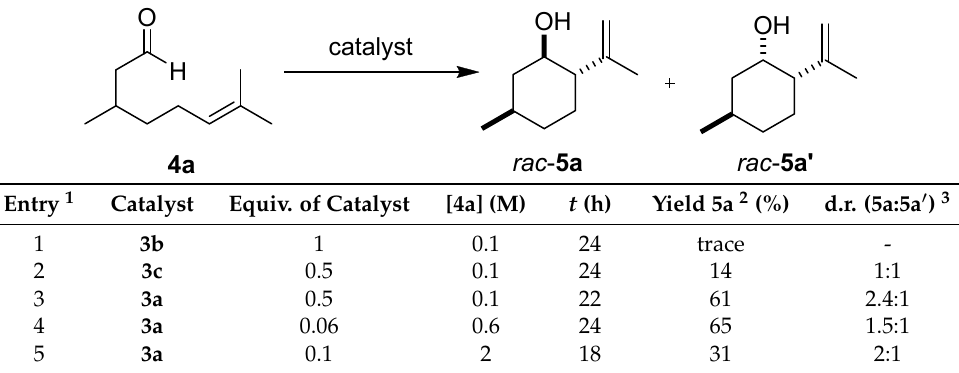
Table 2. Optimization of carbonyl-ene cyclization of citronellal 4a .